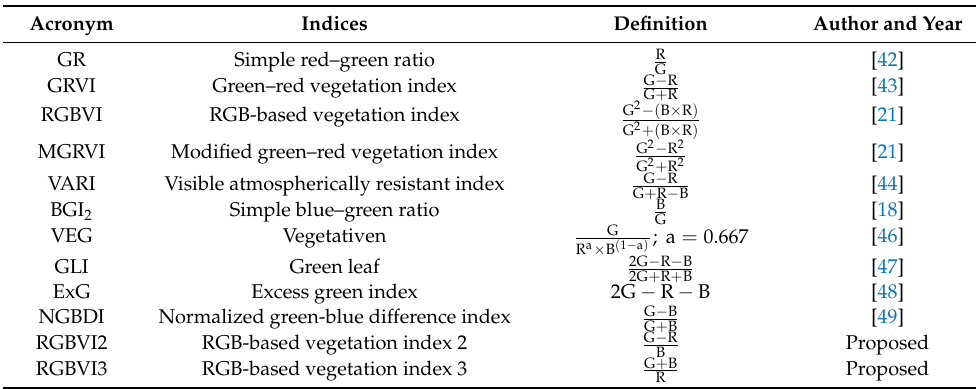
Table 2. Twelve vegetation indices used in this